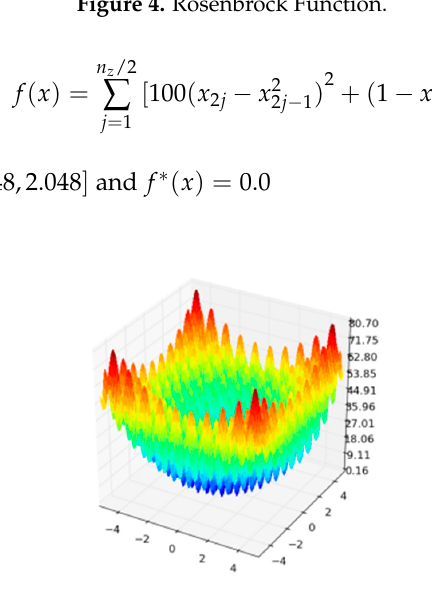
Figure 5. Rastrigin Function.